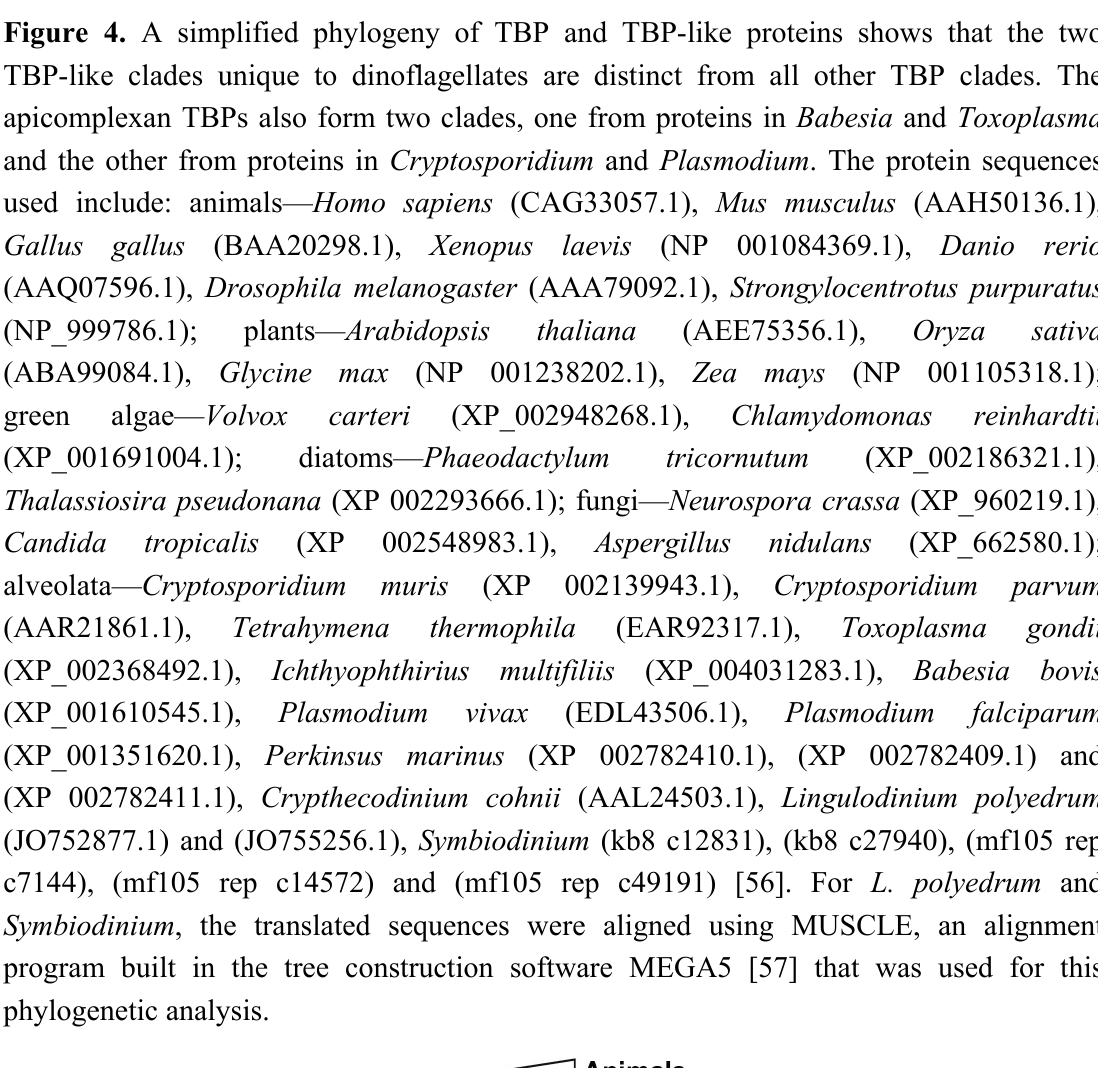
Figure 4. A simplified phylogeny of TBP and TBP-like proteins shows that the two TBP-like clades unique to dinoflagellates are distinct from all other TBP clades. The apicomplexan TBPs also form two clades, one from proteins in Babesia and Toxoplasma and the other from proteins in Cryptosporidium and Plasmodium . The protein